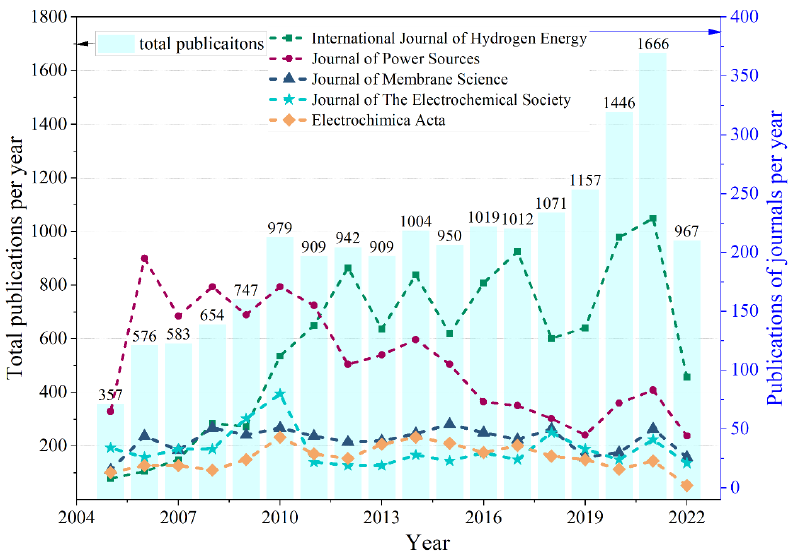
Figure 3. Number of total publications over time and amount comparison of annual publications of the top 5 journals.